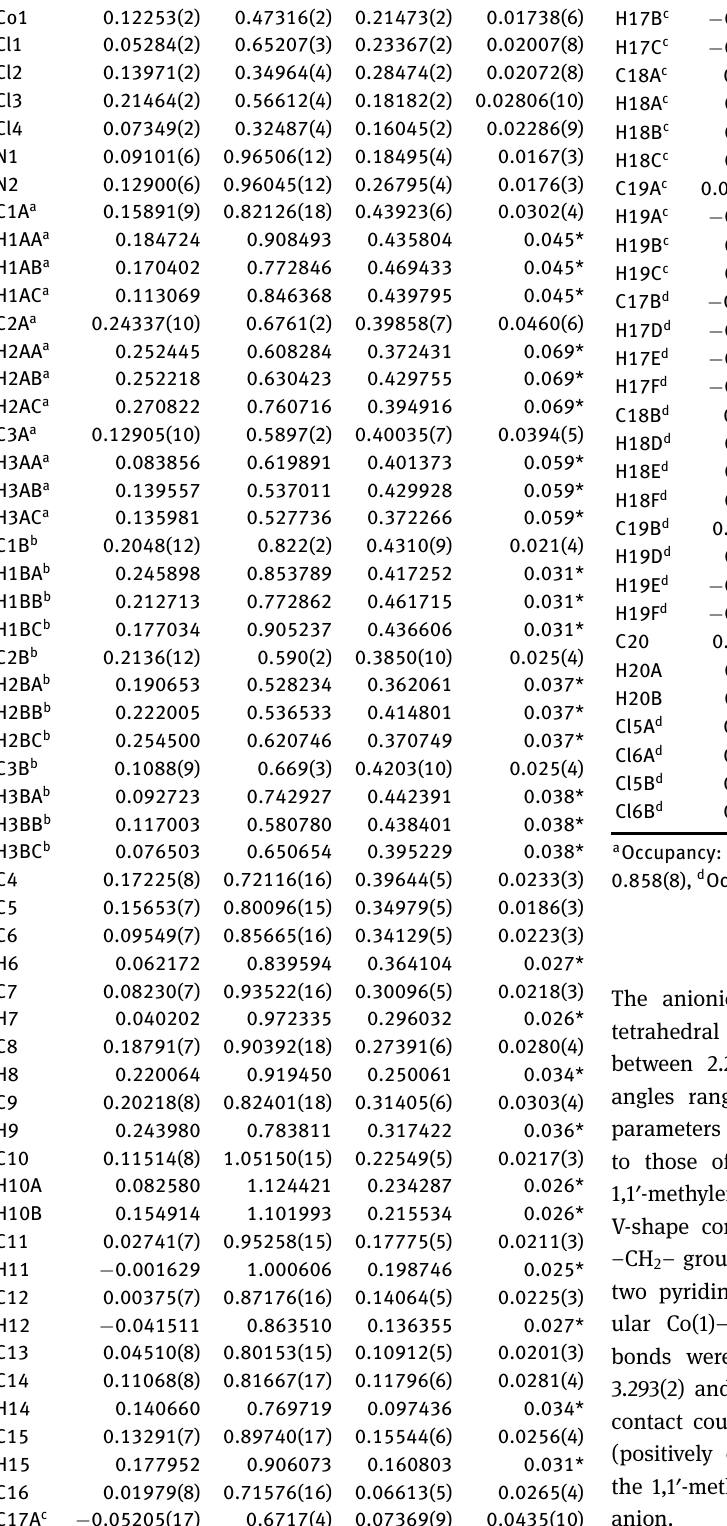
Table 2: Fractional atomic coordinates and isotropic or equivalent isotropic displacement parameters (Å 2 ).